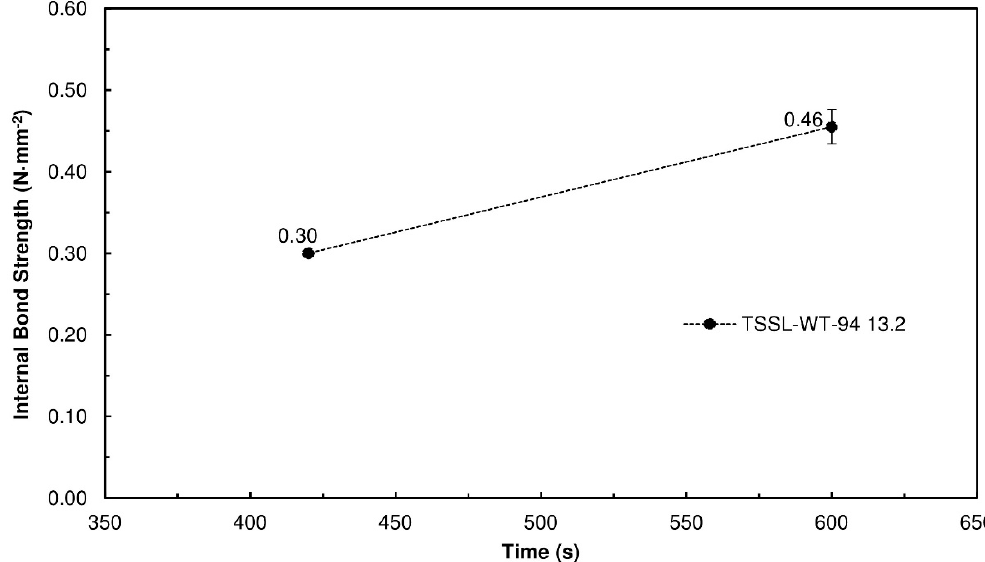
Figure 9. IB strength of the PBs produced with the TSSL+WF-94 as a function of different pressing times; the PBs were manufactured with 13.2% binder solids relative to the dry wood particles and pressed at 190 °C.